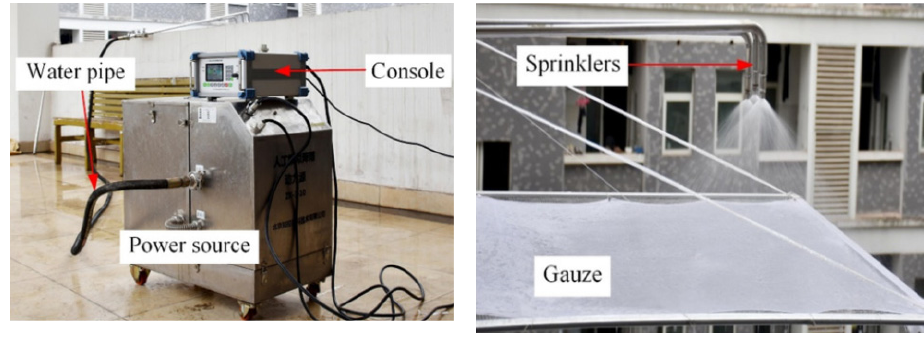
Figure 15. Artificial rainfall device